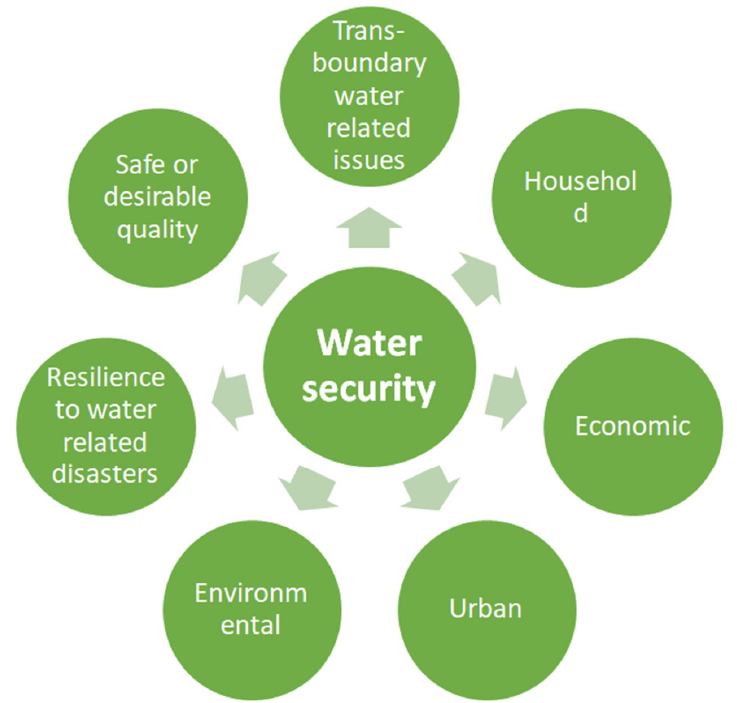
Figure 4. Water security dimensions (based on the Appendix